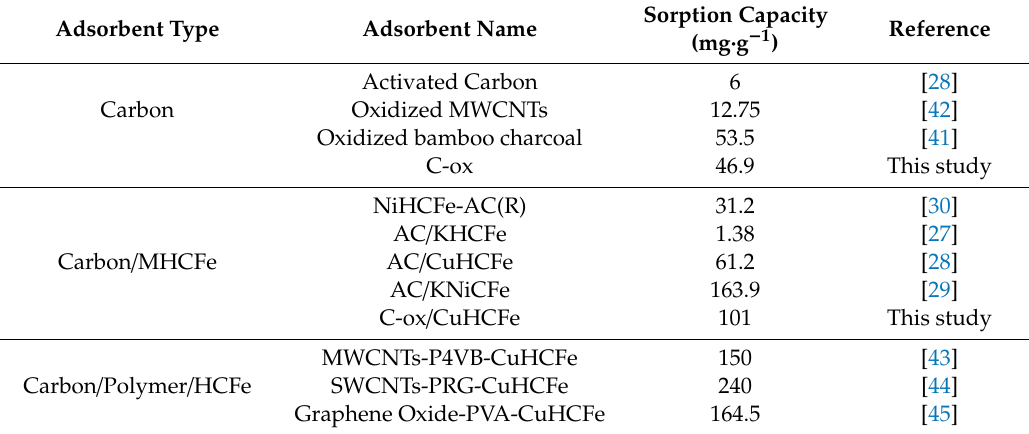
Table 3. Cs + adsorption capacity extracted from the literature for di ff erent